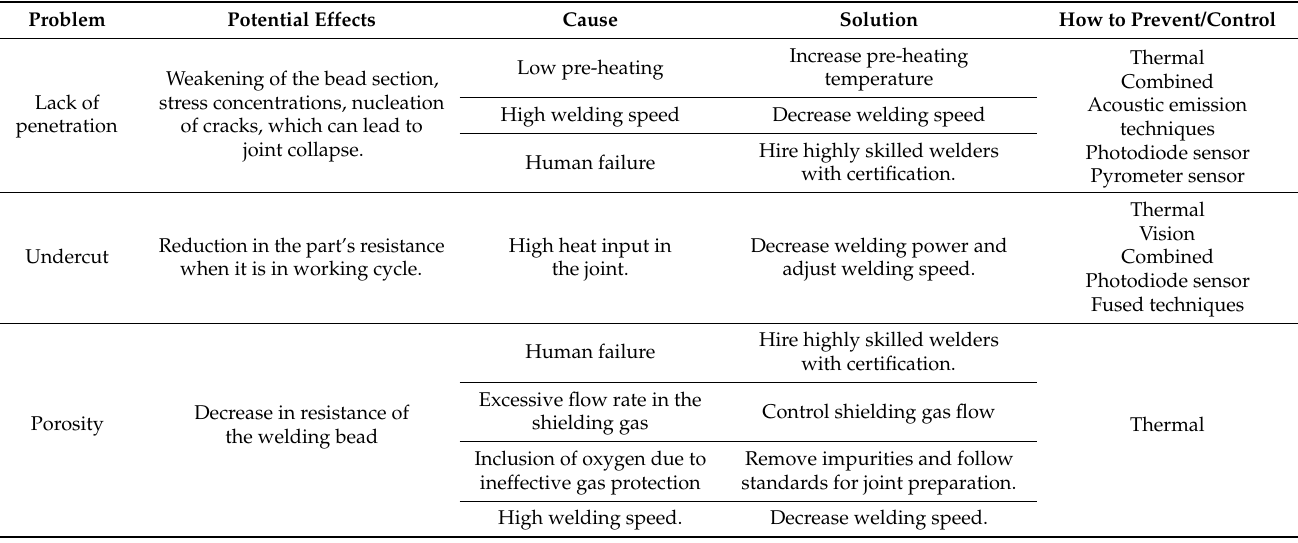
Table 2. Cont. Problem Potential Effects Cause Solution How to Prevent/Control Weakening of the bead section, Lack of stress concentrations, nucleation penetration of cracks, which can lead to joint collapse.